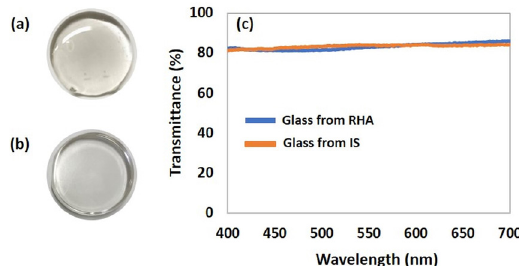
Figure 1. Images of the glasses produced considering as a source of silica: (a) IS and (b) RHA; (c) UV-Vis spectrum of samples (a) and (b).